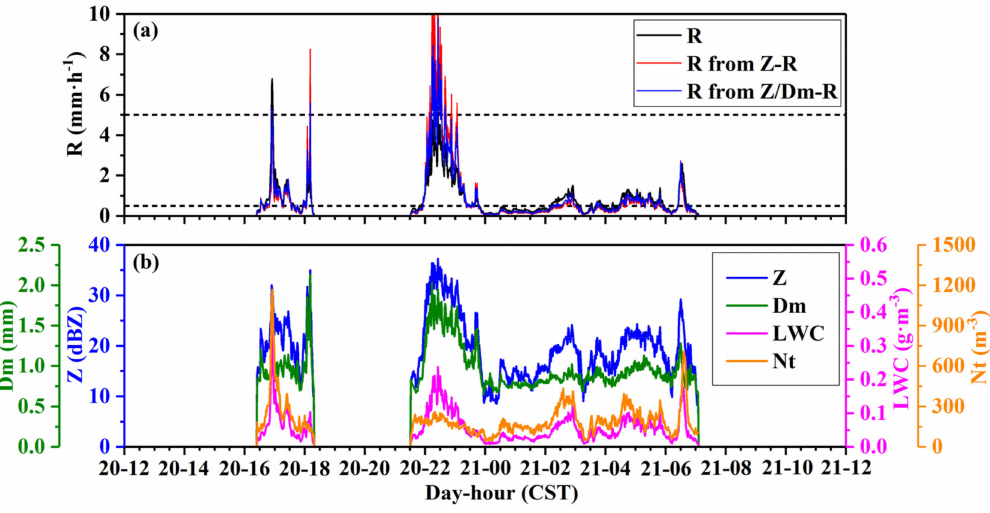
Figure 9. ( a ) Temporal variation of estimated rain intensity (mm · h − 1 ) by using Z − R , Z / D m − R relations and measured by the disdrometer and ( b ) Z (dBZ), Dm (mm), LWC (g · m − 3 ), and N t (m − 3 )